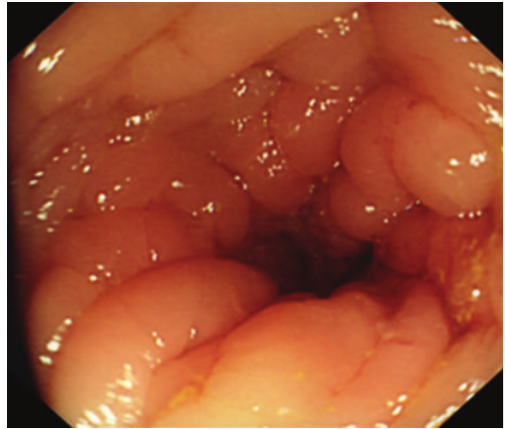
Figure 3: View at sigmoidoscopy showing narrowed lumen, which was felt to be due to a firm and swollen mucosa by the endoscopist.